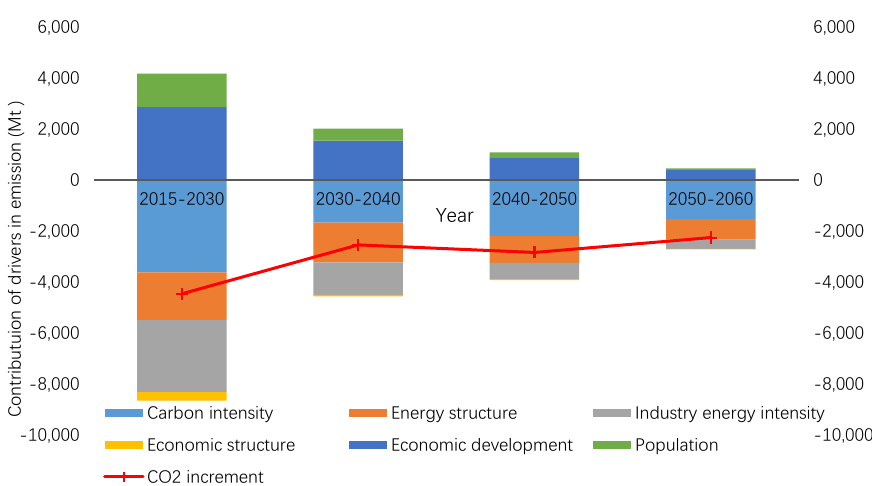
Figure 10. Decomposition of industrial carbon emission from 2015 to 2060.